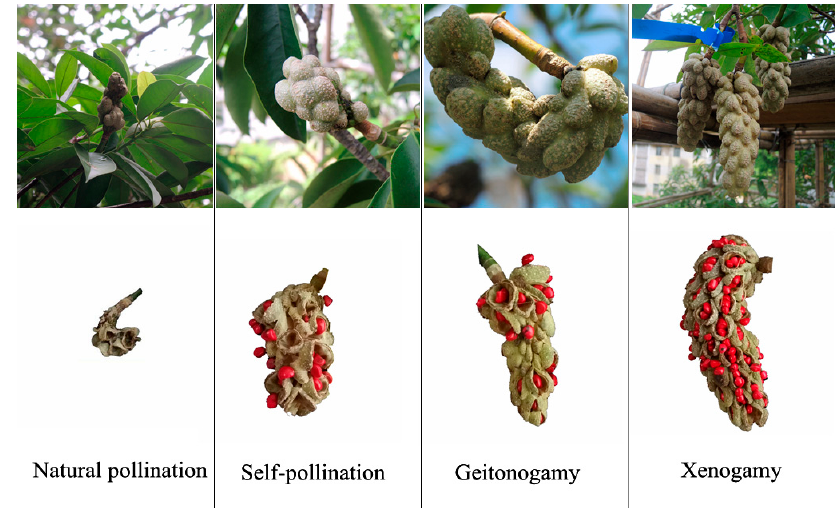
Figure 3. Fructification and fruit of M. conifera after pollination. Table 6. Seed-set in M. conifera following different pollination treatments.